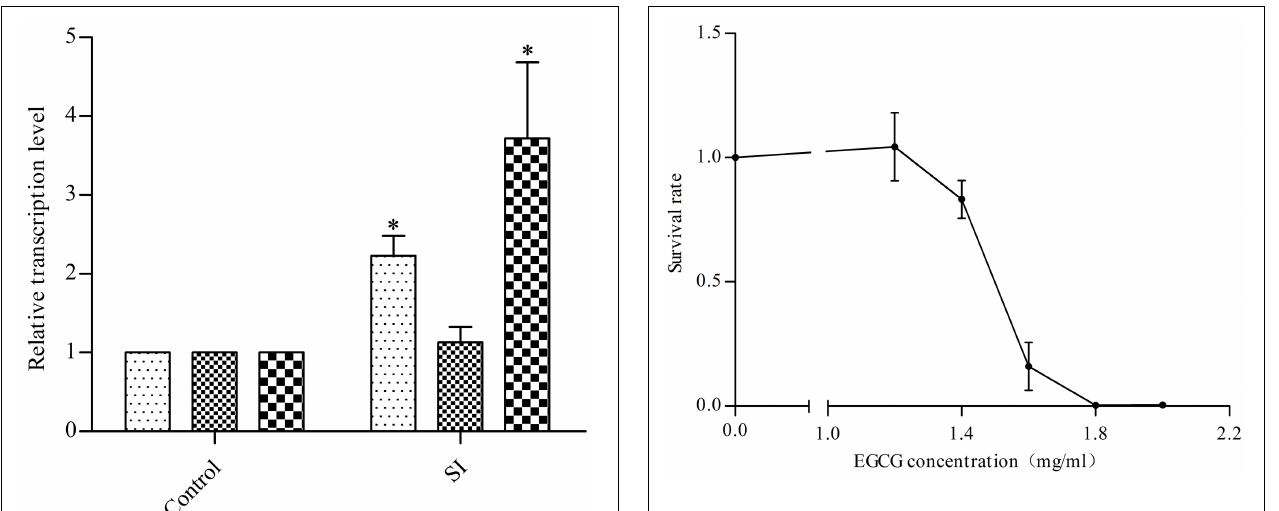
FIGURE 3 | Effects of various concentrations of EGCG on cell survival. Cells without EGCG treatment were used as a control. y axis represents the relative survival rate normalized by the average value of total cells obtained for the control. All values were obtained from at least three biological replicates. Error bars indicate